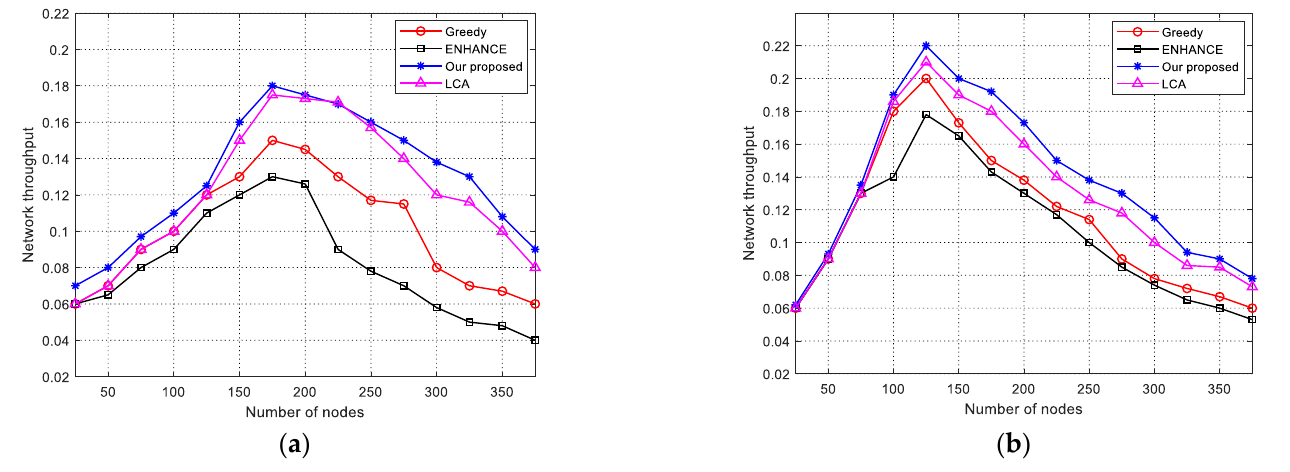
Figure 13. Network throughput with different channel numbers. ( a ) Channel number: 3, ( b ) Channel number: 12.